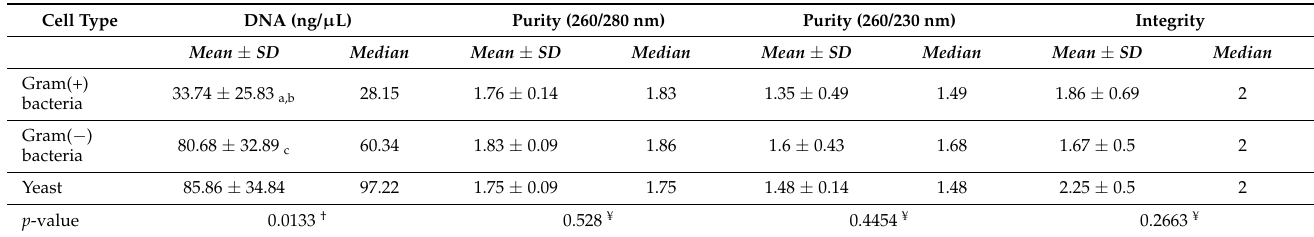
Table 2. Summary of the quantity and quality of DNA extraction by cell type using the CTAB-STD